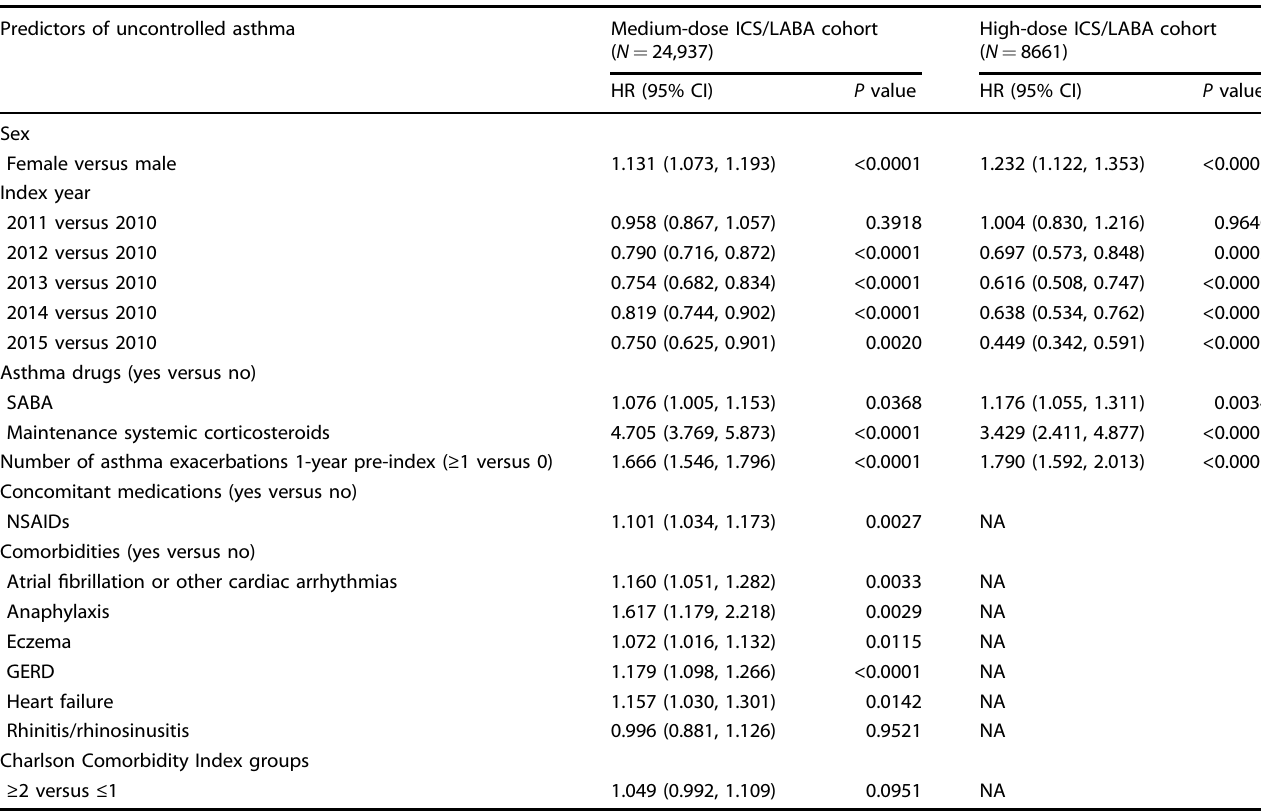
Table 3. Predictors of uncontrolled asthma in medium- and high-dose ICS/LABA cohorts. Predictors of uncontrolled asthma Medium-dose ICS/LABA cohort